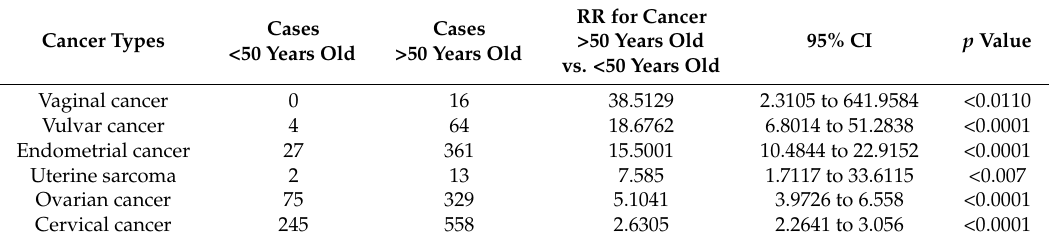
Table 2. Age-related Relative Risk for genital cancer.